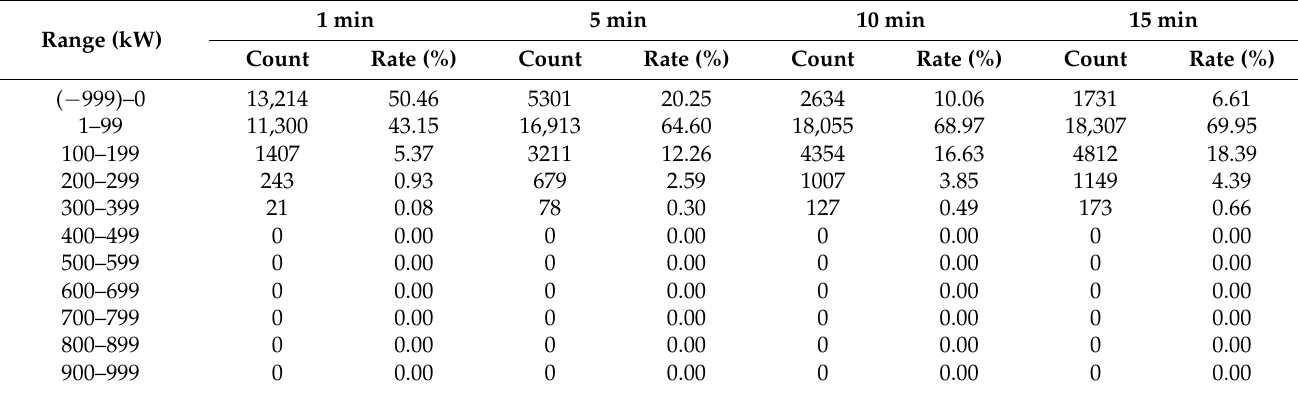
Table 3. Results of the 1, 5, 10, and 15 min